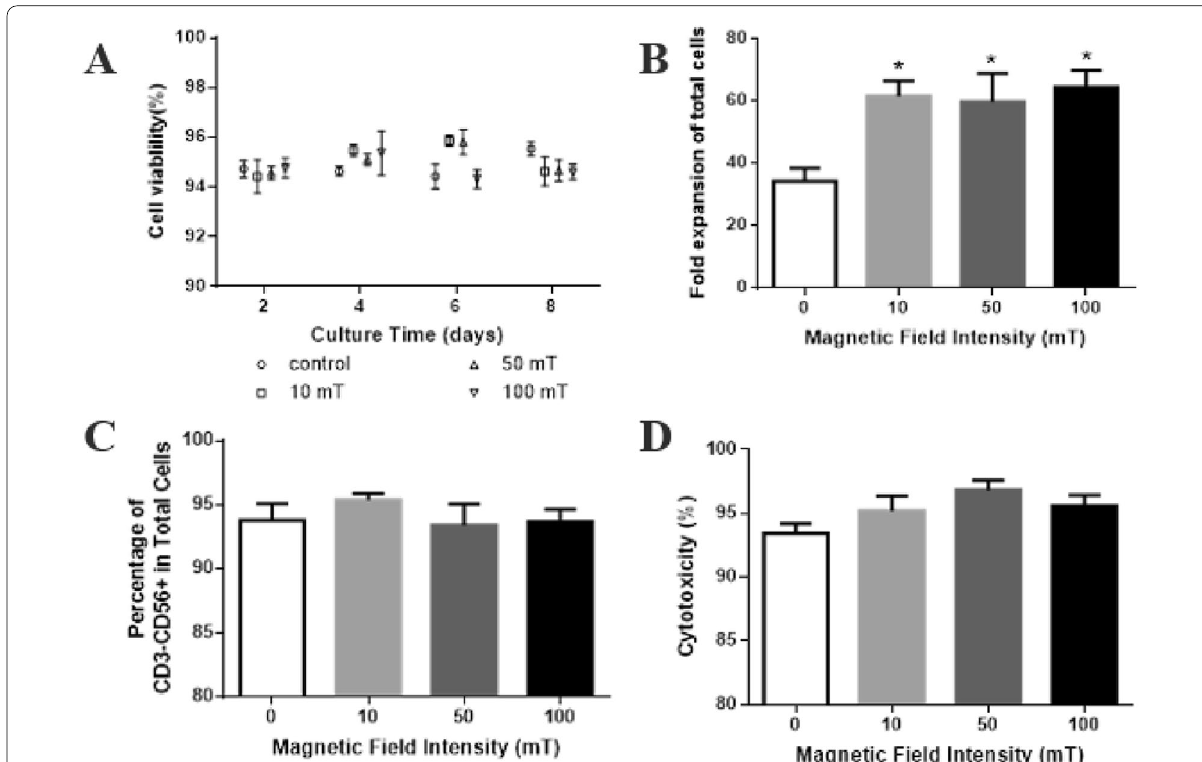
Fig. 4 Effect of intermittent magnetic field on NK‑92 cells NK‑92 cells under. A Cell viability. B Fold expansion of total cells. C Percentage of